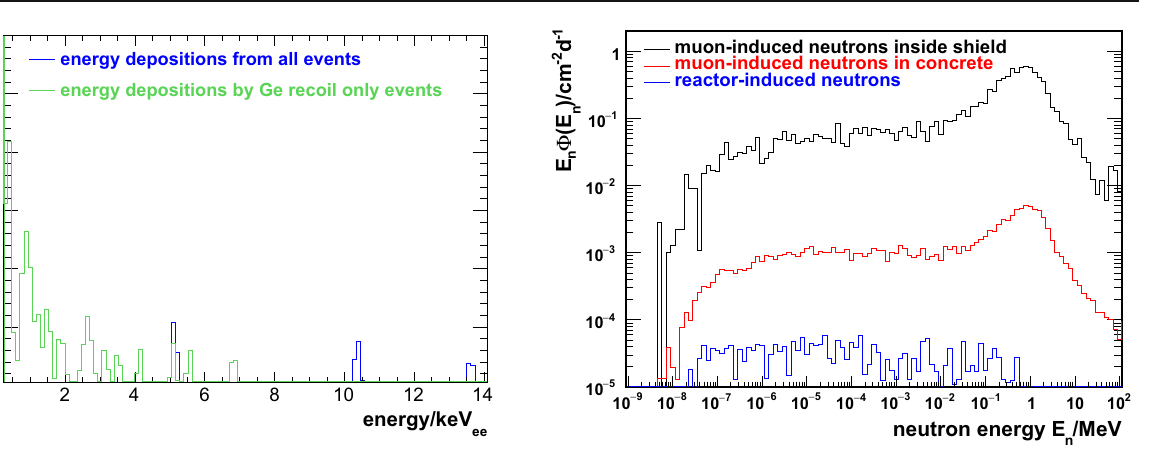
Fig. 26 Expected MC spectrum within an HPGe diode from reactor neutrons at low energies. The outcome of the MC has been adapted to the detector response. Moreover, the spectrum of events consisting of only Ge recoils is displayed